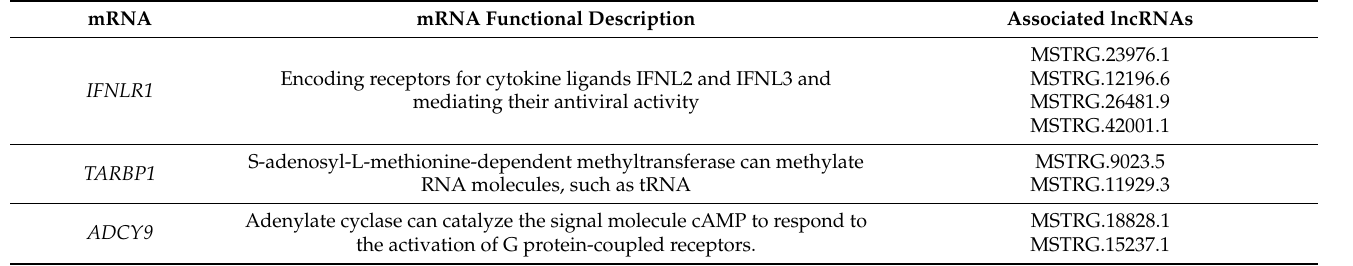
Figure 4. The distribution diagram of Gene Ontology (GO) functions of ( A ) mRNAs and ( B ) lncRNAs in STEM analysis. Table 4. The mRNA (target genes of lncRNAs) and associated lncRNAs in Module 2.